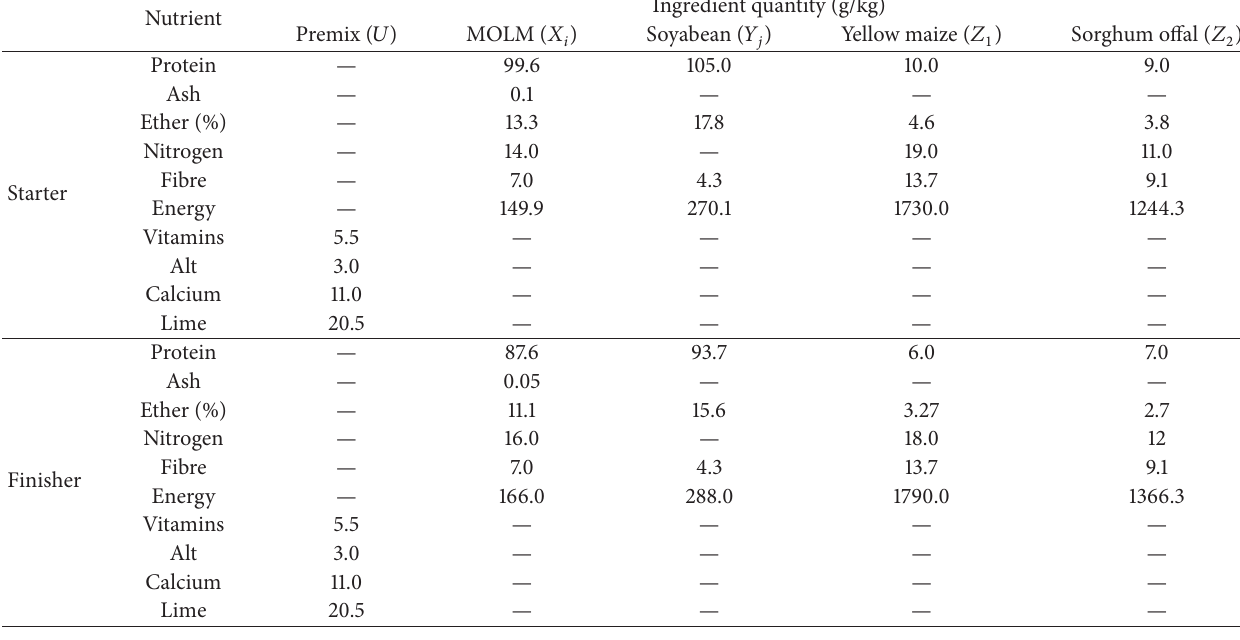
Table 6: Average optimal quantity of nutrients per processed kg of the feed ration.